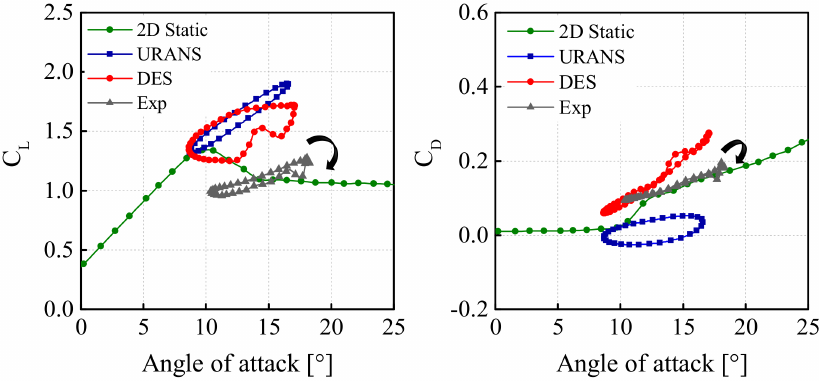
Figure 19. Comparison of C L and C D characteristics at 60% span for inflow speed of 24